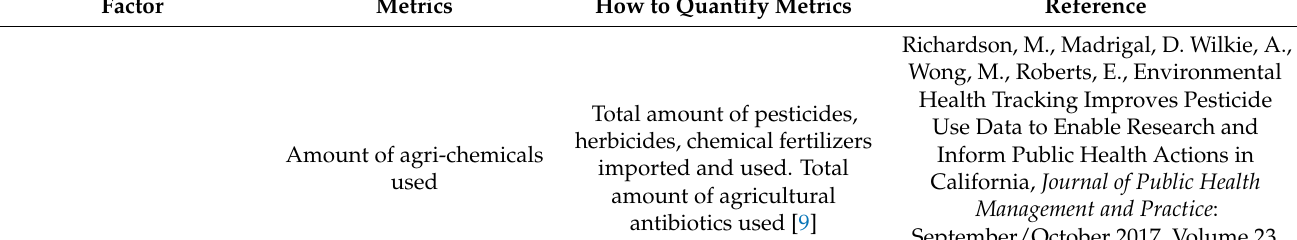
Table 1. Identified Factors, Metrics for Factors, and How to Quantify Metrics. This table is the result of research into different quantification methods for the factors being addressed in this proposed analytical framework. Factor Metrics How to Quantify Metrics Reference